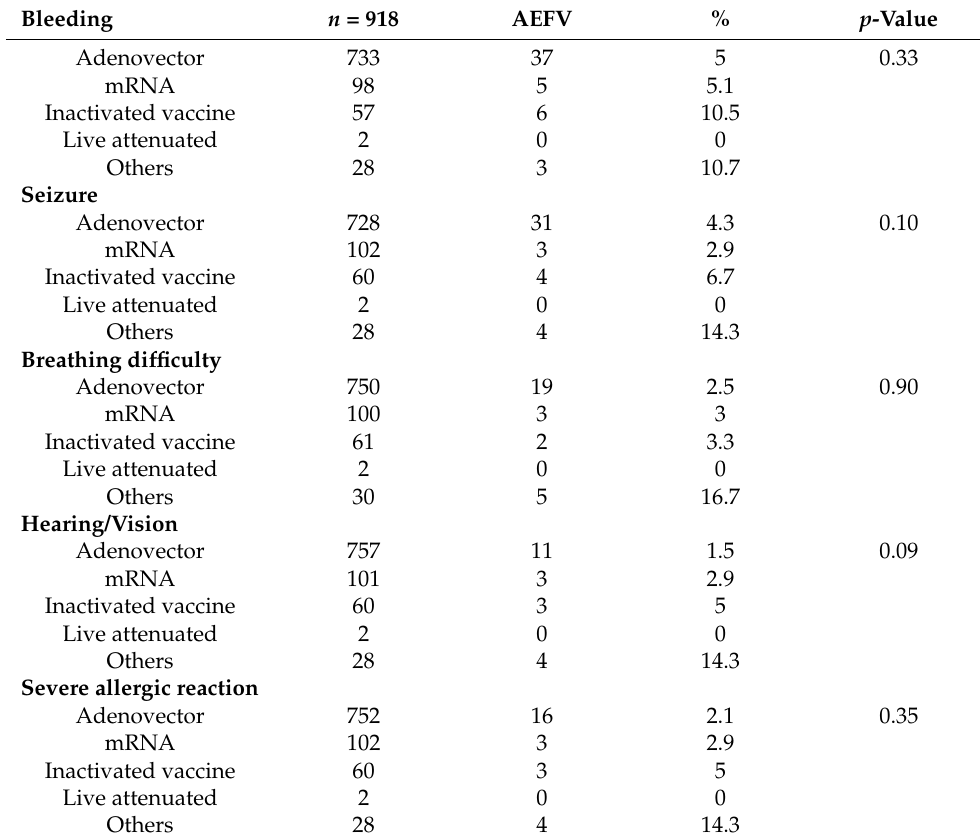
Table 5. Comparison of adverse events in adenoviral vaccines vs. others for COVID-19 in Africa. Bleeding n = 918